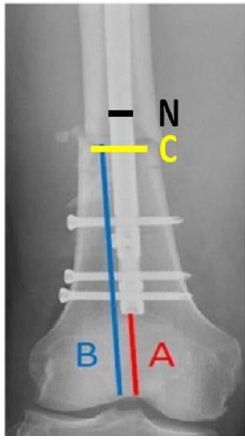
Figure 2. Ratio of the unfixed distal segment: A/B. A: Distance from the tip of the nail to the intercondylar notch in the AP view, B: main distal fragment length from the proximal fracture line to the intercondylar notch in the AP view. Ratio of the IM canal diameter to nail size at the level of fracture: C/N. C: IM canal diameter at the level of fracture in the AP view, N: nail size in the AP view. Statistical